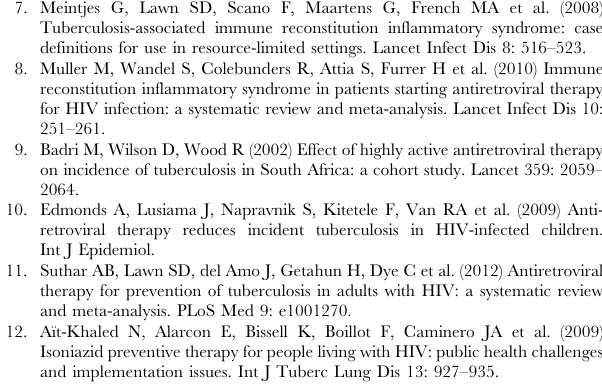
Table S1 List of all ART programs participating in the survey and which completed at least Section A (n =58), including programs treating adults, children, or both. Sites marked with a star are programs treating children only and were therefore excluded from the present analysis. Table S2 Eight hypothetical cases typical for different clinical situations in the context of HIV and tuberculosis management. Table S3 Characteristics of adult tuberculosis (TB) patients seen during the study period from antiretrovi- ral (ART) programs in lower income countries, overall and stratified by IeDEA regions. Table S4 Availability of TB diagnostics in 47 adult ART programs in lower income countries, by IeDEA regions. Table S5 Diagnostic tools as part of the screening practices to diagnose active TB in HIV-infected individ- uals before starting ART in 47 adult ART programs in